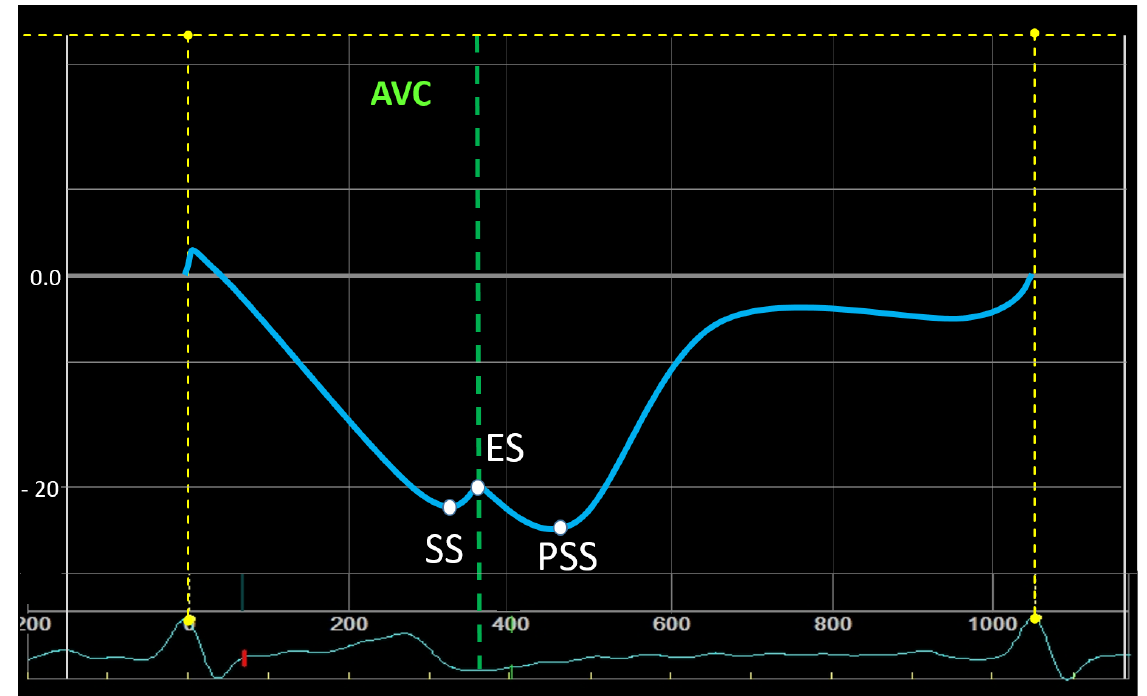
Figure 2. Overview and definition of commonly used strain measurements. Peak systolic strain (SS) is always measured before aortic valve closure (AVC). End-systolic strain (ES) is measured on AVC. Post-systolic strain (PSS) peaks after